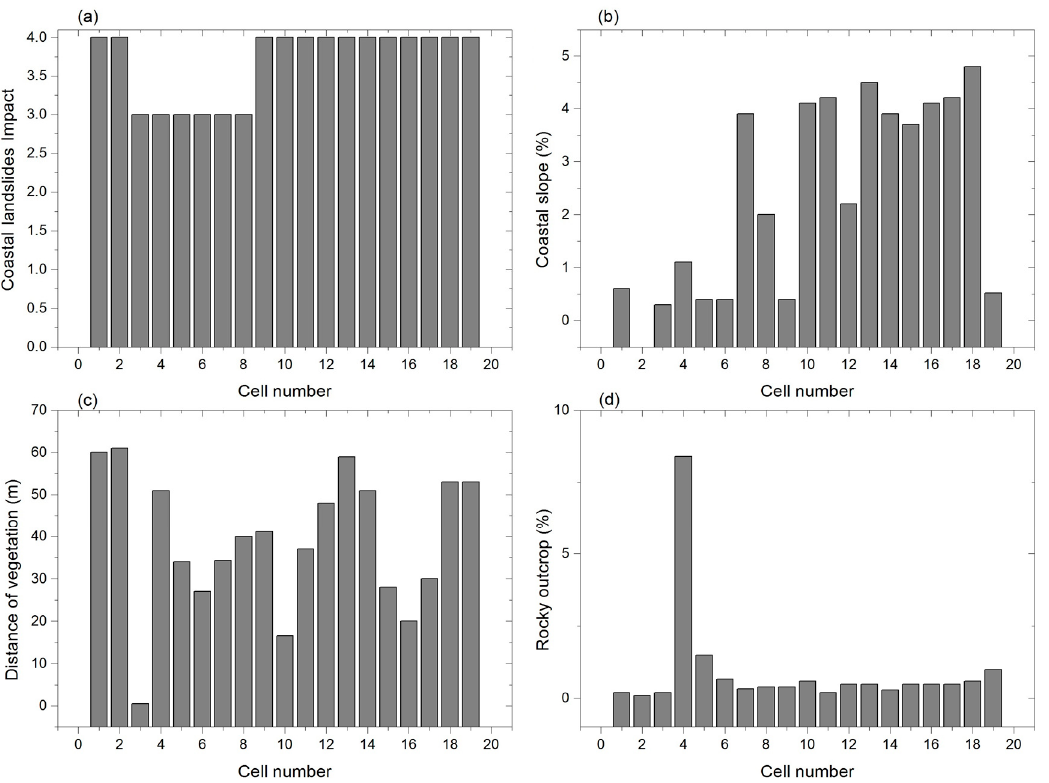
Figure 4. Distribution of all parameters scores. ( a ) Coastal landslide’s impact; ( b ) Coastal slope; ( c ) Distance of vegetation; ( d ) Rocky outcrop.